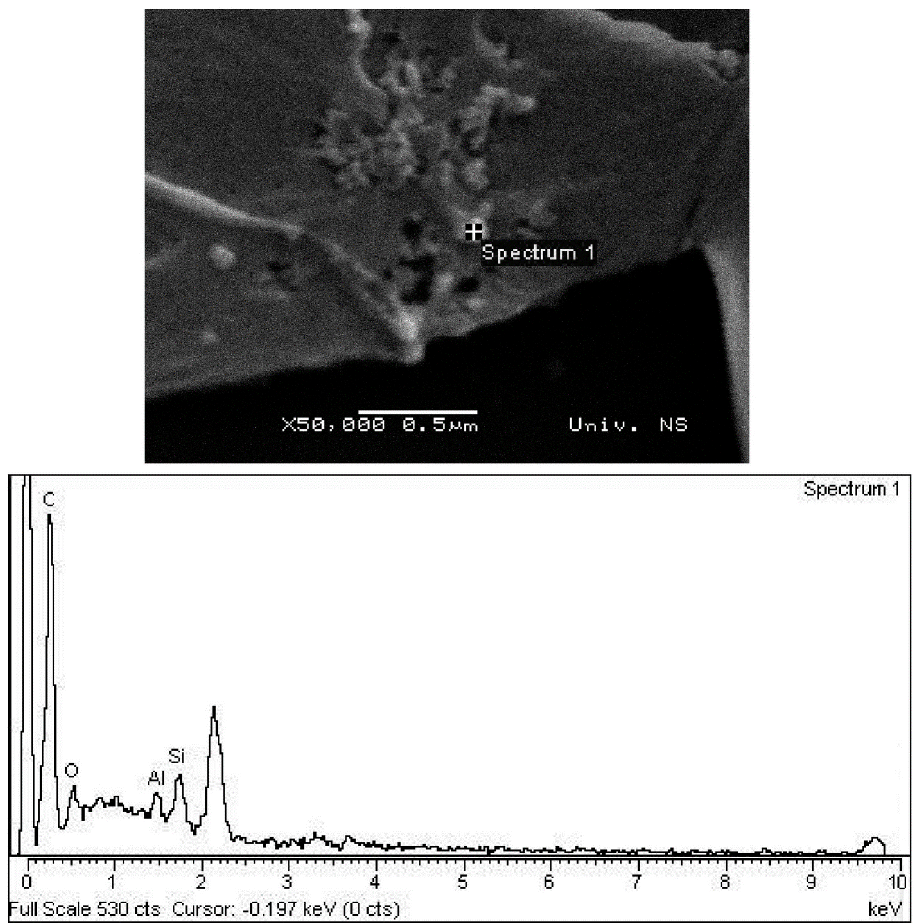
Figure 4. SEM images of fracture surface with a cluster of agglomerates (specimen modified with 2% nanoparticles) and EDX spectrum of particles. The analyzed spectrum contains Si and O, indicating that the point of interest is SiO 2 cluster of particles.